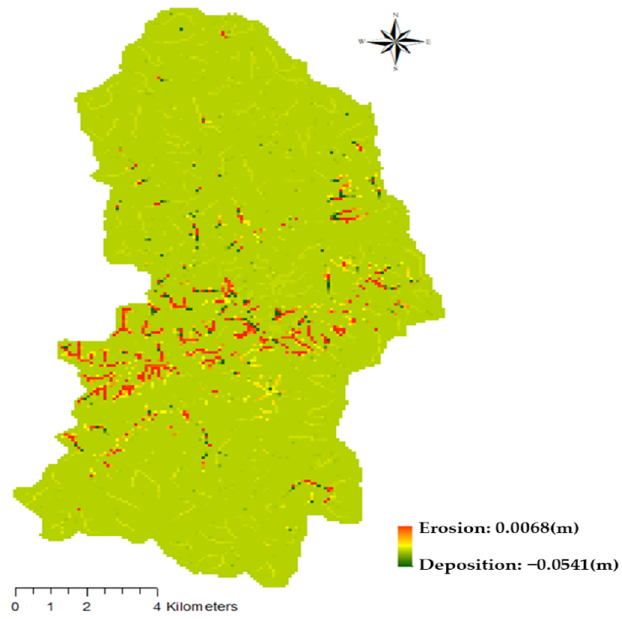
Figure 12. Spatial distribution of net erosion by the calibrated MR-SSEM (Typhoon Maemi).